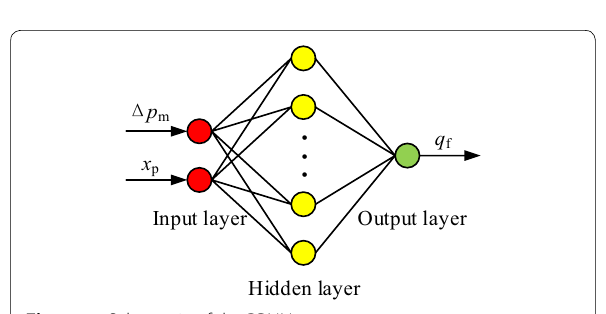
Figure 4 Schematic of the